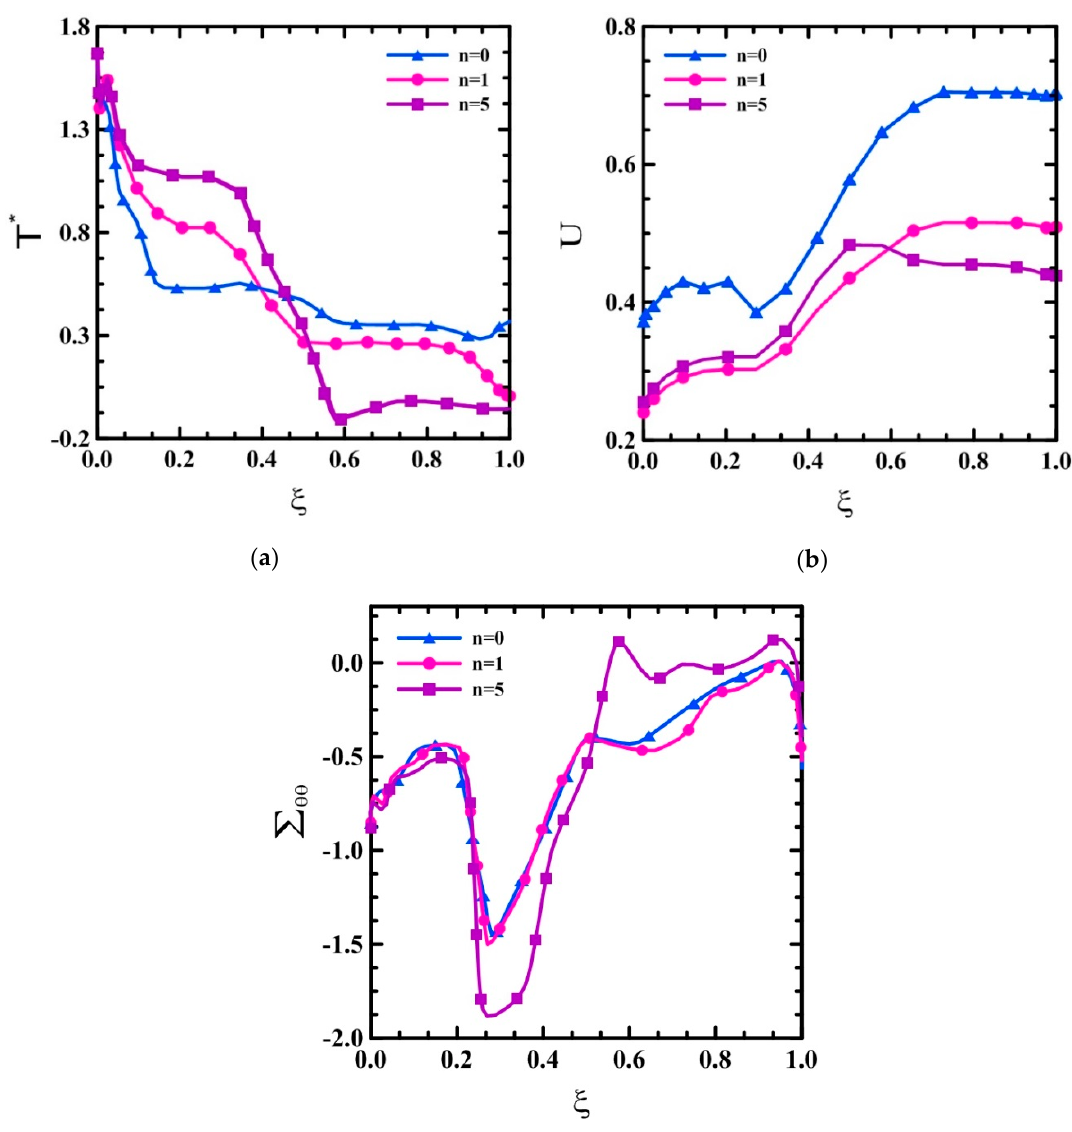
Figure 5. ( a – c ): Effect of the material gradient index n on the distribution of the thermoelastic field variables through the radial direction for the FG cylindrical panels with piezoelectric layers (cid:16) (cid:17) h c / h p = 5, θ 0 = 75 ◦ , ψ = 0.03, θ = 0.5 θ 0 , F 0 = 0.8, τ = 0.2